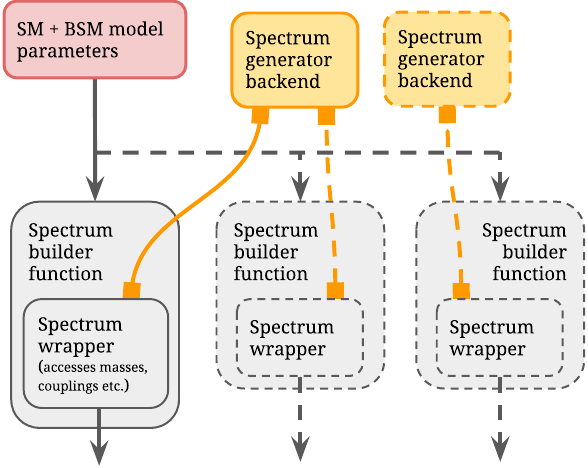
Fig. 1 Schematic representation of the structure of SpecBit . Model parameters (red box) are obtained from the GAMBIT Core and fed to SpecBit module functions (grey boxes). These module functions run spectrum generator backend codes (yellow boxes) and embed the results within Spectrum wrapper objects (inner grey boxes), which carry the spectrum information out to other GAMBIT functions that require it. In some cases the backend code remains connected to the wrapper object, allowing RGEs to be called to translate couplings and mass parameters to other scales. In this diagram solid outlines indicate “active”elementsforahypotheticalscan,whiledashedoutlinesindicate inactive elements. The “active” elements are those that are activated by the central GAMBIT dependency resolution system, or manually run in a standalone code. The “inactive” elements represent alternate calculation pathways not required in a scan, but can be switched on instead if the user